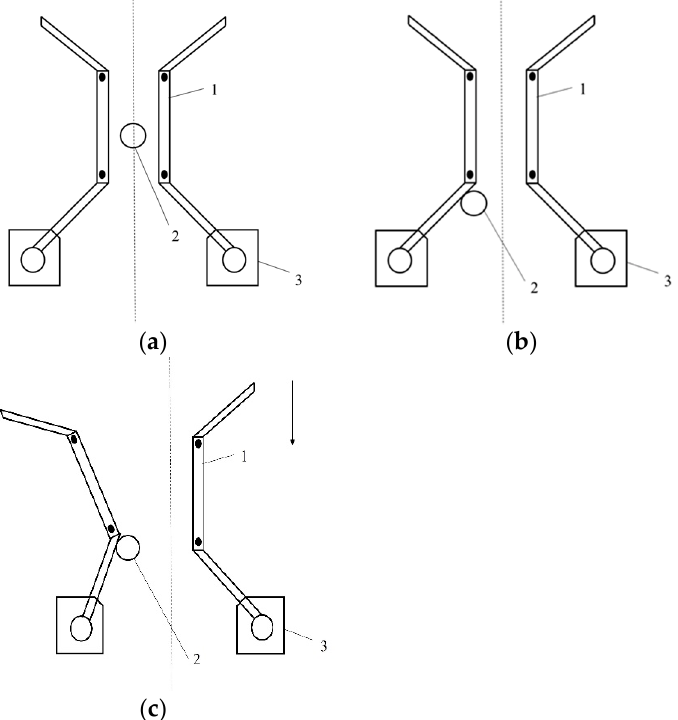
Figure 5. Schematic diagram of the action of the touch-to-travel mechanism (1) Touch lever (2) Corn stalk (3) Touch sensor holder. ( a ) Automatic row close; ( b ) Automatic row start; ( c ) Auto row ending.